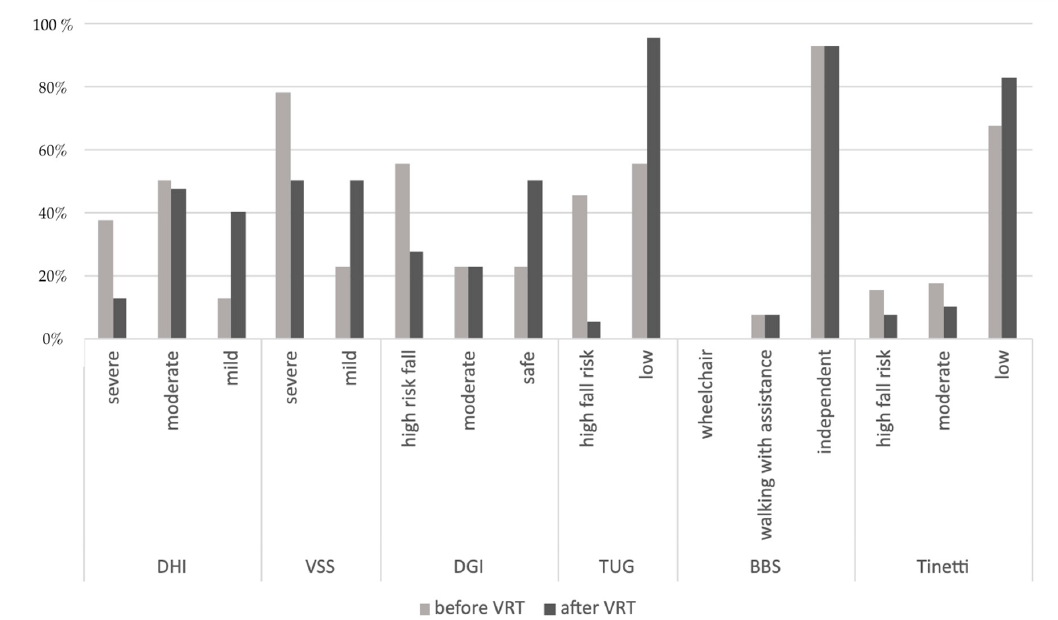
Figure 2. The non-instrumental tests—the percentage distributions of patients before and after VRT.